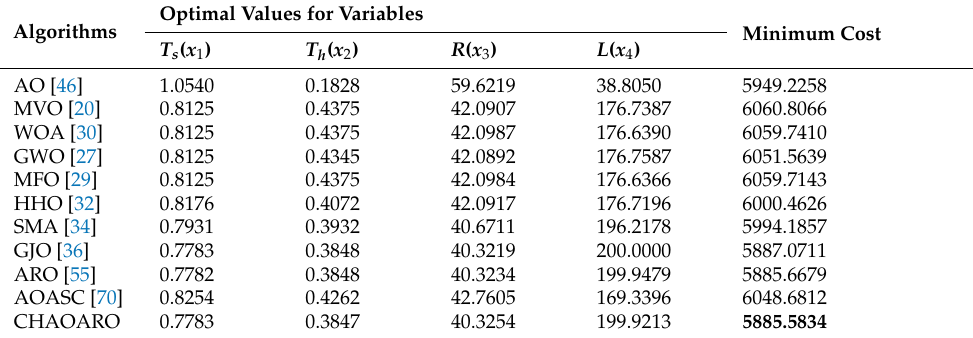
Table 12. Comparison results for pressure vessel design problem.